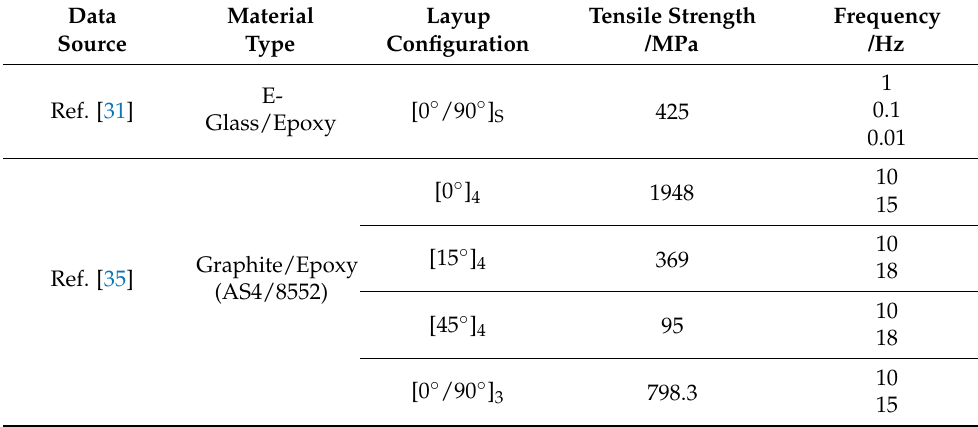
Table 3. Tensile strength and test frequency of unidirectional and cross plies from Ref.